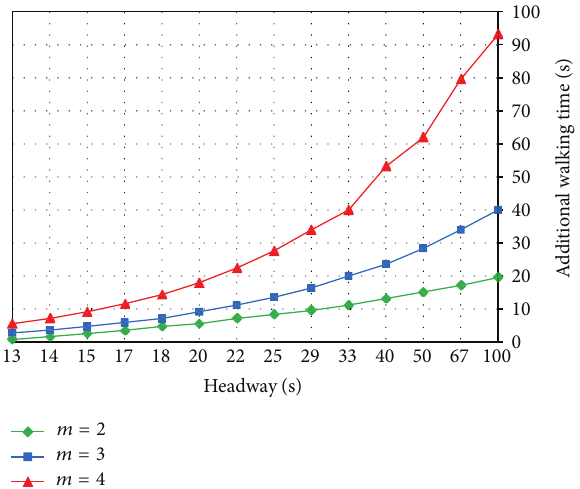
Figure 5: Additional walking time at different arrival rate of buses for various berths, 𝜇 𝑏 = 0.04 veh /